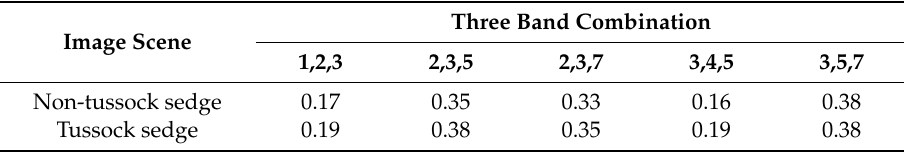
Table 1. Summary statistics of Absolute Mean relative Error (AMRE) for candidate